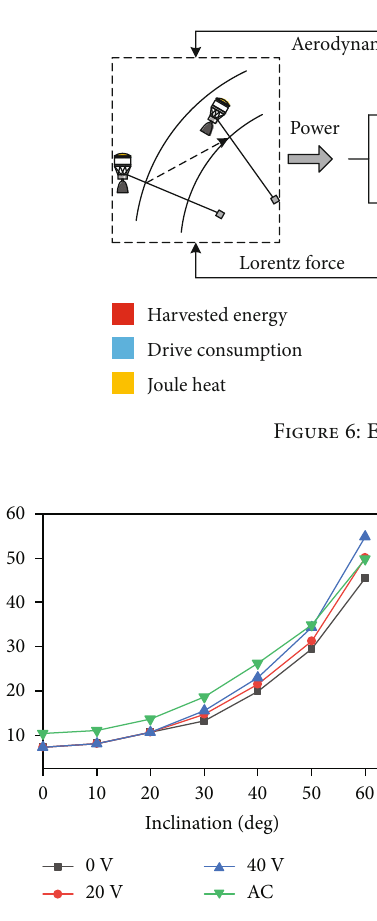
Figure 7: Comparison with the results of deorbiting durations obtained by Sánchez-Arriaga et al.